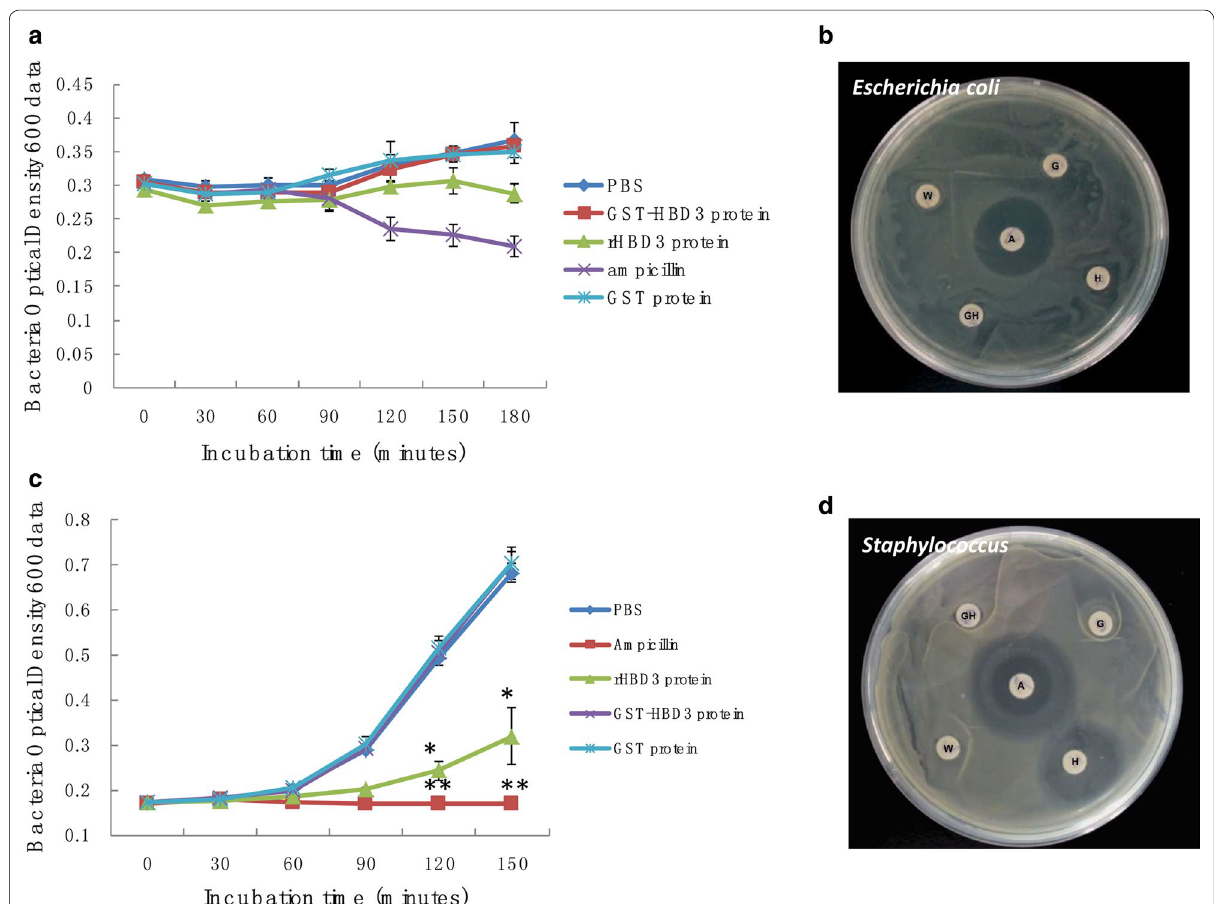
Fig. 3 Anti-bacterial capacity analysis of rHBD3 protein by E. coli and Staphylococcus . a Anti-bacterial action of different proteins (GST-HBD3, HBD-3, GST, ampicillin) treated on BL21 (DE3) strain. In this experiment, the final concentration of GST tag protein, GST-HBD3 fusion protein, and rHBD3 protein was 20 μg/ml. b Inhibition zone of different protein (GST-HBD3, HBD-3, GST, AMP) on E. coli of BL21 (DE3) stain ( W water, G GST tag, GH GST- HBD3 fusion protein, H recombination HBD3 protein, A ampicillin). c Anti-bacterial action of different proteins (GST-HBD3, HBD-3, GST, and AMP) treated on Staphylococcus aureus (ATCC 25923) strain. In this experiment, the concentration of GST tag protein, GST-HBD3 fusion protein, and rHBD3 protein was 10 μg/ml. d Inhibition zone of different proteins (GST-HBD3, HBD-3, GST, and AMP) on S. aureus (ATCC 25923) strain ( W water, G GST tag, GH GST-HBD3 fusion protein, H recombination HBD3 protein, A